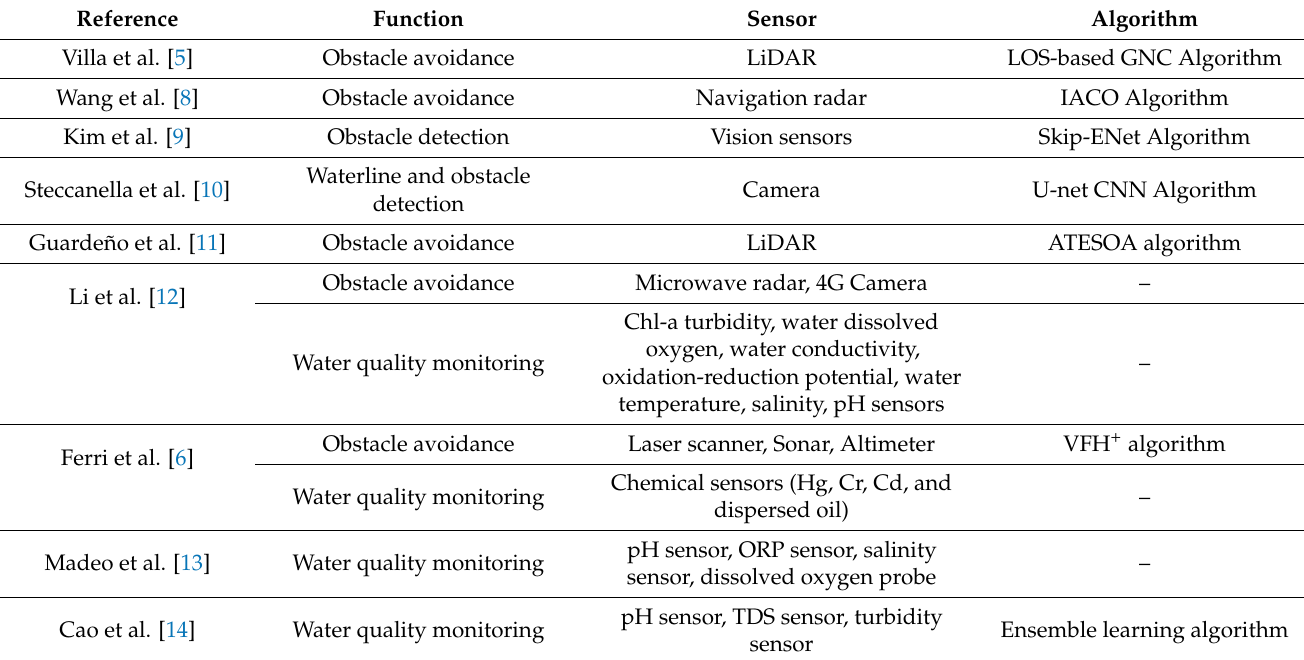
Table 1. Function comparison of the proposed multi-function unmanned surface vehicle (MF-USV) with some existing USVs/autonomous surface vehicles